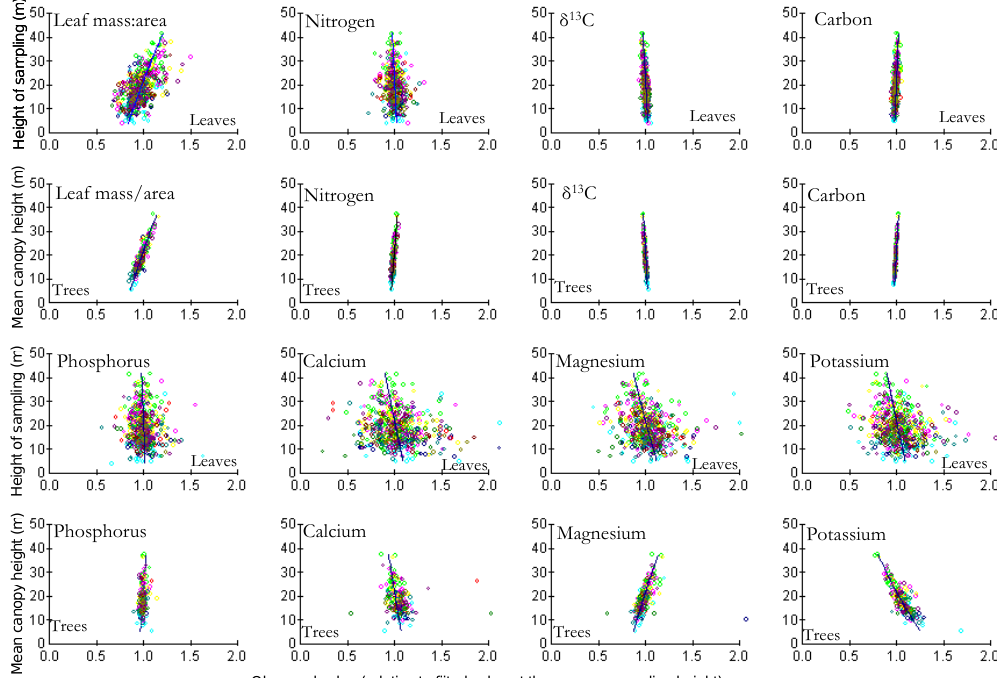
Fig. 7. Observed values and fitted lines for within-tree gradients (“Leaves”) and tree-to-tree gradients (“Trees”) for leaf mass per unit area, [N] DW , [C] DW , δ 13 C, [P] DW , [Ca] DW , [Mg] DW and [K] DW for 204 trees sampled across Amazonia. Different colours refer to different